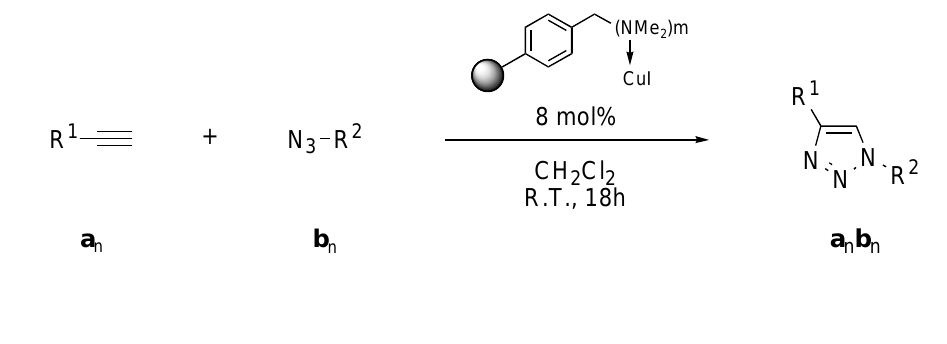
1 0 99 7 0 99 1 99 8 1 99 3 2 99 9 2 99 4 3 99 10 3 99 5 4 99 11 4 99 6 5 99 12 5